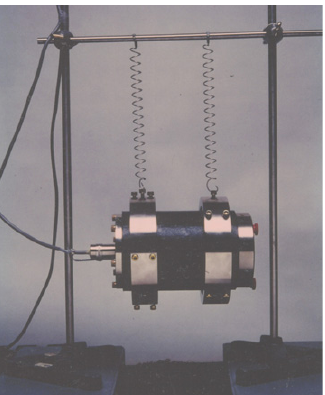
Fig. 15. Sealed and vibration isolated measurement chamber for determining the inherent noise of condenser microphones and their preamplifiers. The volume of the chamber is about 2000 cm 3 . The shown chamber has been applied for testing low-noise microphones with an inherent A-weighted noise level below 0 dB.